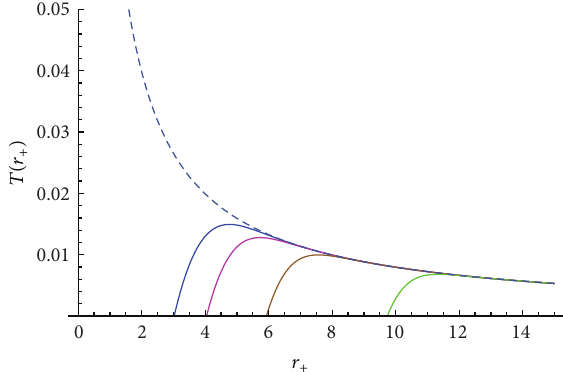
Figure 5: Plot of 𝑇(𝑟 + ) as a function of 𝑟 + in √𝜃 -units for 𝑘 = 0 (blue), 𝑘 = 1 (magenta), 𝑘 = 4 (brown), and 𝑘 = 15 (green). The dashed line represents the classical case; that is, 𝜃 = 0 .